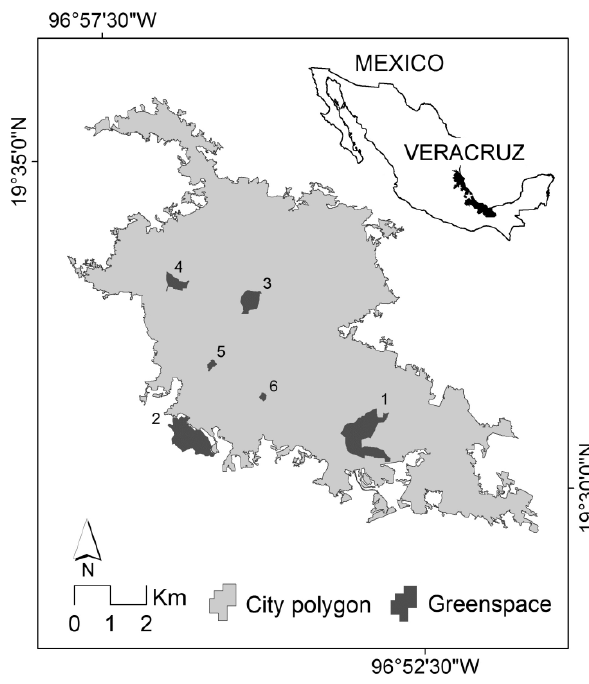
Figure 1. Greenspace location in Xalapa (light gray polygon). 1: Natura; 2: Santuario; 3: Macuiltépetl;